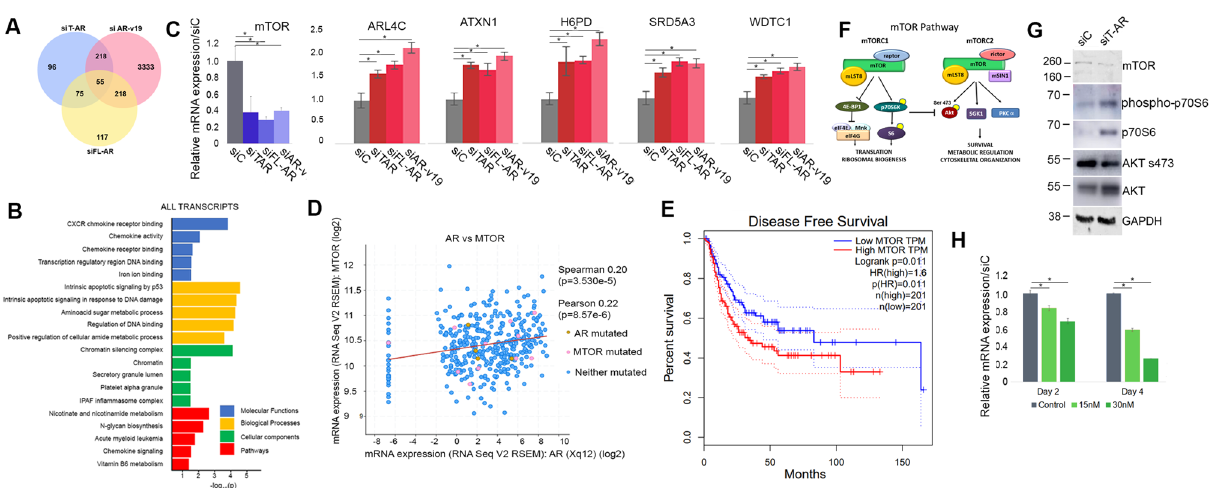
Figure 5. Transcriptome of cells overexpressing the AR-v19 isoform. ( A ) Western blot confirm highly elevated AR-v19 in AR-v19 overexpressing UM-UC-3 cells. ( B ) Volcano plot analysis shows equivalent number of transcripts elevated and decreased in AR-v19 overexpressing cells when compared to UM-UC-3 cells harboring the parental expression vector PCDNA3. ( C ) Heatmap of altered transcripts in AR-v19 overexpressing cells compared to cells harboring the parental vector. ( D ) Molecular function (blue), biological processes (yellow) cellular components (green) and pathways (red) altered in AR-v19 overexpressing cells. ( E ) qRT- PCR validation of transcripts regulated in AR-v19 overexpression. ( F ) Comparison of transcript regulation on AR-v19 depletion and overexpression. Transcripts were divided into those exclusively altered after AR-v19 depletion (green) or AR-v19 overexpression (indigo), and those inversely regulated, upregulated on AR-v19 depletion, and downregulated on AR-v19 overexpression (light green) and downregulated on AR-v19 depletion and upregulated on AR-v19 overexpression (light indigo). Transcripts commonly altered in both models are shown in grey. ( G ) Heatmap of inversely regulated transcripts. ( H ) qRT-PCR validation of transcripts inversely regulated on AR-v19 overexpression or depletion. I Gene enrichment analysis of the identified transcripts. Molecular function (blue), biological processes (yellow) cellular components (green) and pathways (red) inversely altered in AR-v19 depleted and overexpressing cells. ( I ) qRT-PCR validation of selected inversely regulated transcripts. J. Pathway interactions of the most significantly inversely regulated components: up on AR-v19 depletion (indigo), up on AR-v19 overexpression (green). Immunoblots were cropped prior to incubation with specific antibodies.